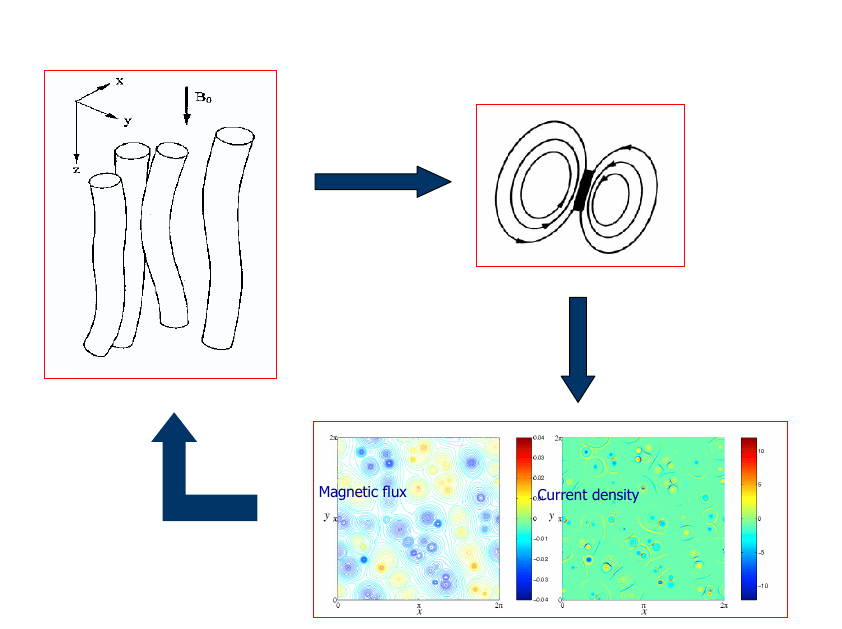
Figure 102: Composite figure made adapting original figures from the paper by Chang et al. (2004). The first element on the upper left corner represents field-aligned spatio-temporal coherent structures. A cross-section of two of these structures of the same polarity is shown in the upper right corner. Magnetic flux iso-contours and field polarity are also shown. The darkened area represents intense current sheet during strong magnetic shear. The bottom element of the figure is the result of 2D MHD simulations of interacting coherent structures, and shows intermittent spatial distribution of intense current sheets. In this scenario, new fluctuations are produced which can provide new resonance sites, possibly nucleating new coherent